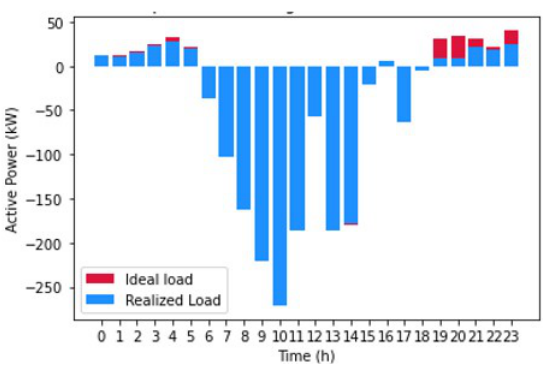
Figure 13. Proposed dispatch for the microgrid at the end of the hierarchical